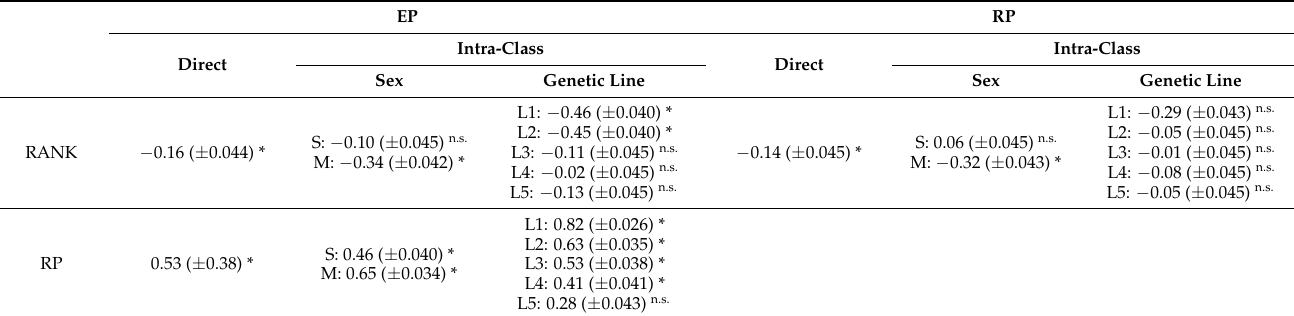
Table 2. Direct and intra-class Pearson’s correlations ( ± standard error) according to sex and genetic line effects, between effort phase (EP) and recovery phase (RP) and the ranking position (RANK), where S refers to the stallions, M to the mares, L1 is the German genetic line, L2 is the Thoroughbred genetic line, L3 is the Trotter genetic line, L4 is the Pura Raza Española genetic line, and L5 is the Other Breeds genetic line. * p < 0.05; n.s. not statistically